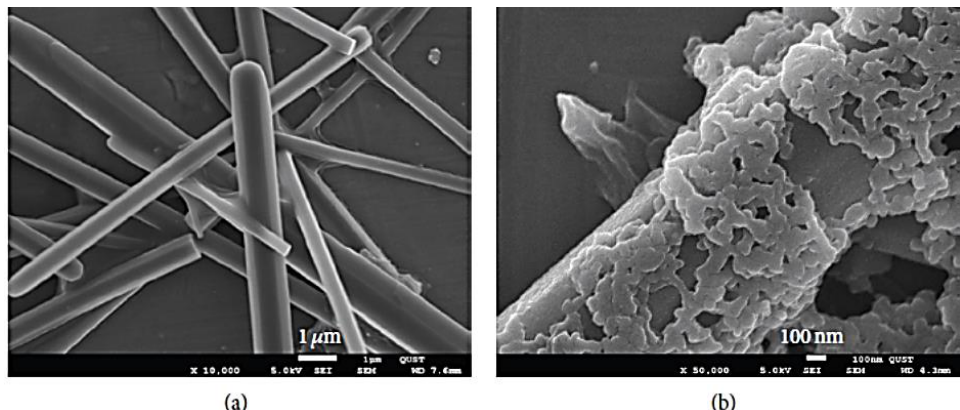
Figure 3. Antibacterial activity of a polyaniline nanomaterial [97]. Reproduced with permission from Elsevier.